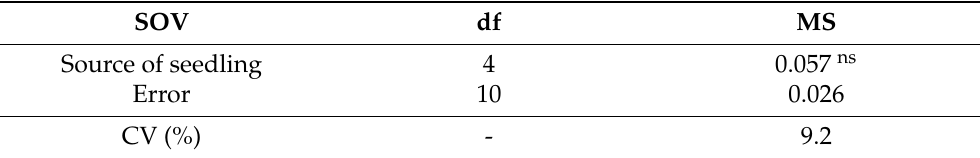
Table 7. Analysis of variance for soluble proteins obtained from seedlings originating from zygotic and synthetic